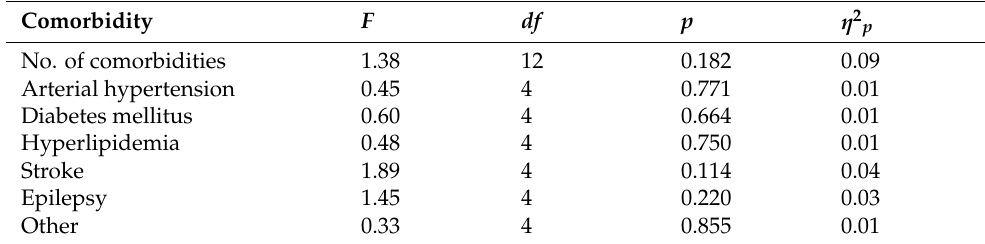
Figure 2. Mean Mg 2+ concentration and standard errors of the mean for the concentration of Mg 2+ ions in individual measurements. Table 2. Mg 2+ serum concentration vs.